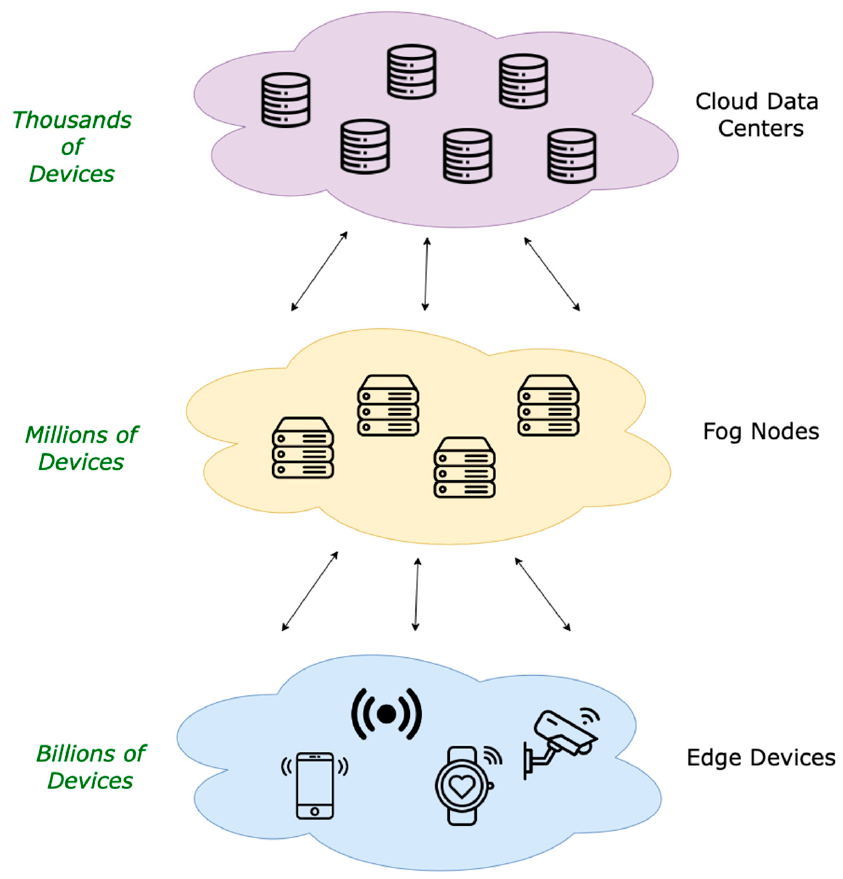
Figure 3. Cloud, fog, and edge computing hierarchy.